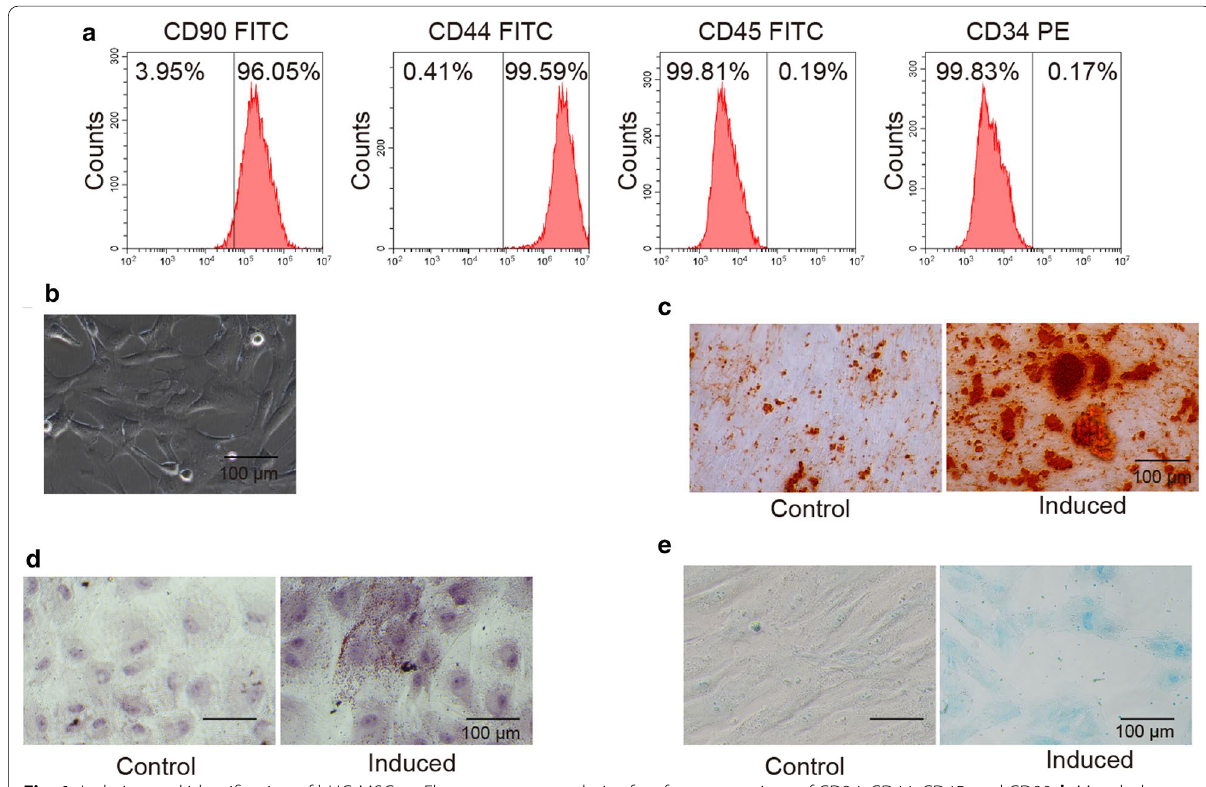
Fig. 1 Isolation and identification of hUC‑MSCs. a Flow cytometry analysis of surface expressions of CD34, CD44, CD45, and CD90. b Morphology of hUC‑MSCs after 3 weeks’ culture. c Alizarin red staining of hUC‑MSCs after 3 weeks’ culture in osteogenic medium. d Oil red oranse staining of hUC‑MSCs after 3 weeks’ culture in adipogenic medium. e Alcian blue staining of hUC‑MSCs after 3 weeks’ culture in chondrogenic